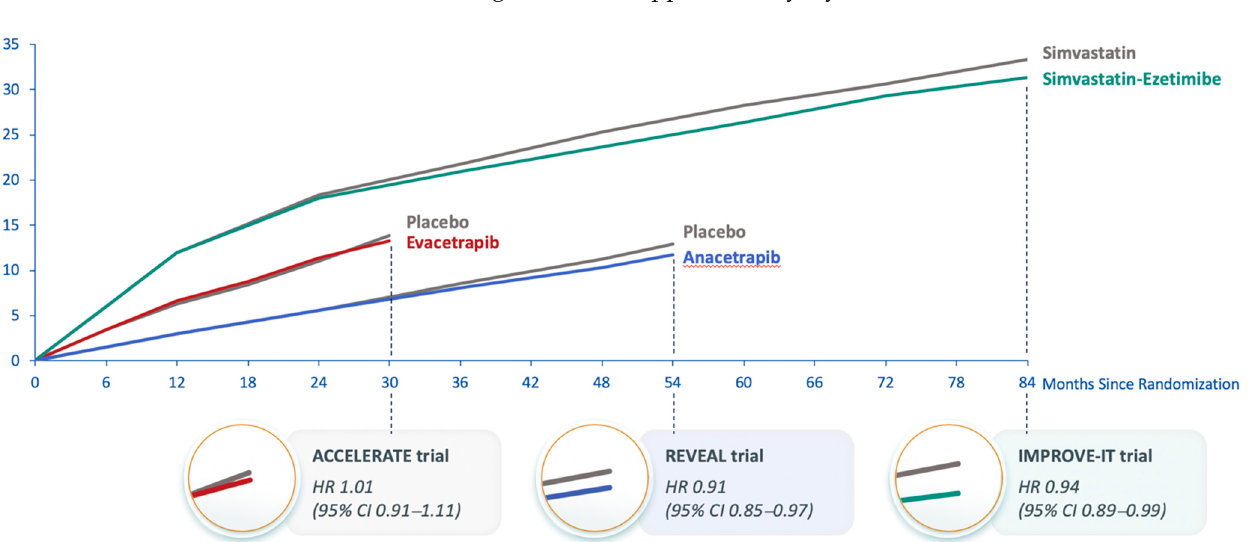
Figure 2. Kaplan–Meier curves from cardiovascular outcome trials of anacetrapib, evacetrapib and ezetimibe. Abbreviations: ACCELERATE, Assessment of Clinical Effects of Cholesteryl Ester Transfer Protein Inhibition with Evacetrapib in Patients at a High Risk for Vascular Outcomes; CI, confidence interval; HR, hazard ratio; IMPROVE-IT, Improved Reduction of Outcomes: Vytorin Efficacy International Trial; REVEAL, Randomized Evaluation of the Effects of Anacetrapib through Lipid-modification.